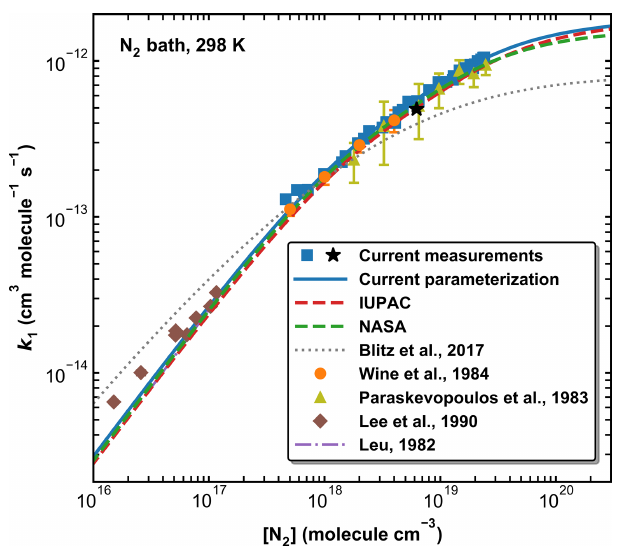
Figure 10. A comparison of previous measurements of k 1 at 298K (N 2 bath gas only) with our parameterization and those of IUPAC, NASA, and Blitz et al. (2017b) (see Table 2 for details). The black star represents the measurement using HONO photolysis at 351nm to generate